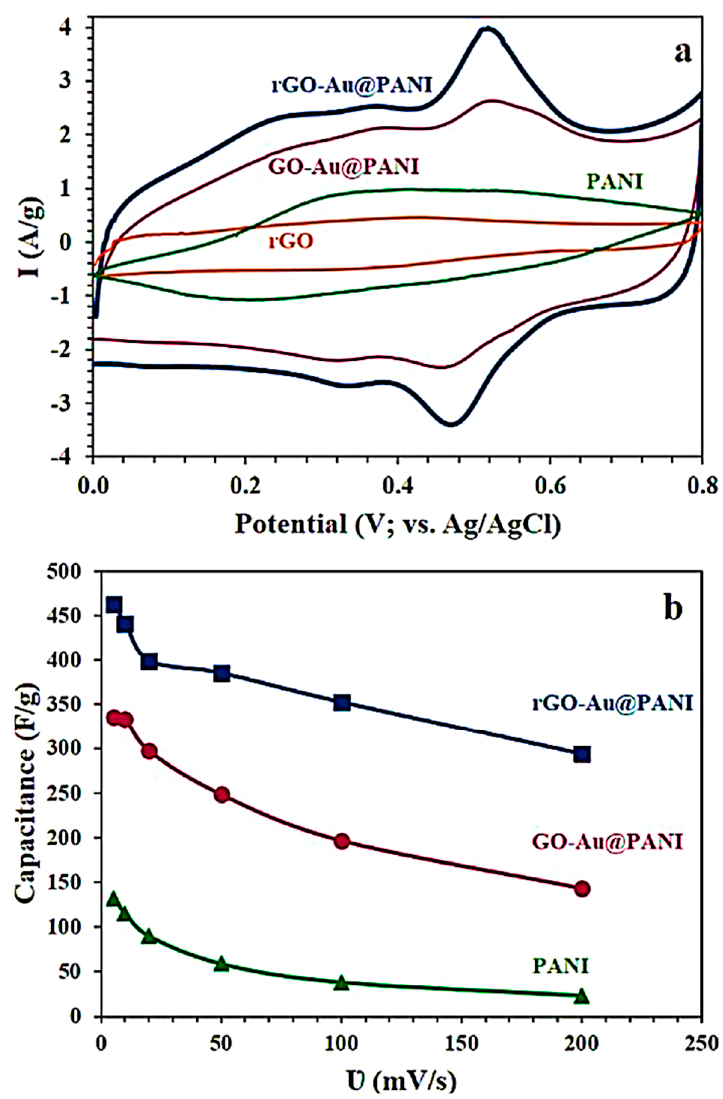
Figure 9. ( a ) CV curves of rGO, pristine PANI, rGO-Au@PANI, and GO-Au@PANI at scan rate of 10 mV/s in 1 M H 2 SO 4 electrolyte; CV curves and ( b ) Variation of specific capacitance vs. scan